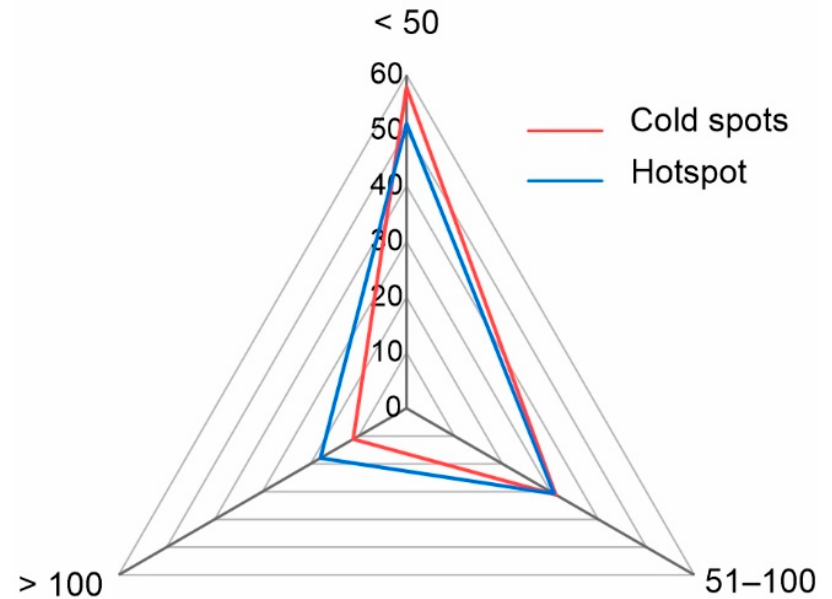
Figure 7. Variation in WQI in CKDu cold spots and hotspots in the Yan Oya river basin.